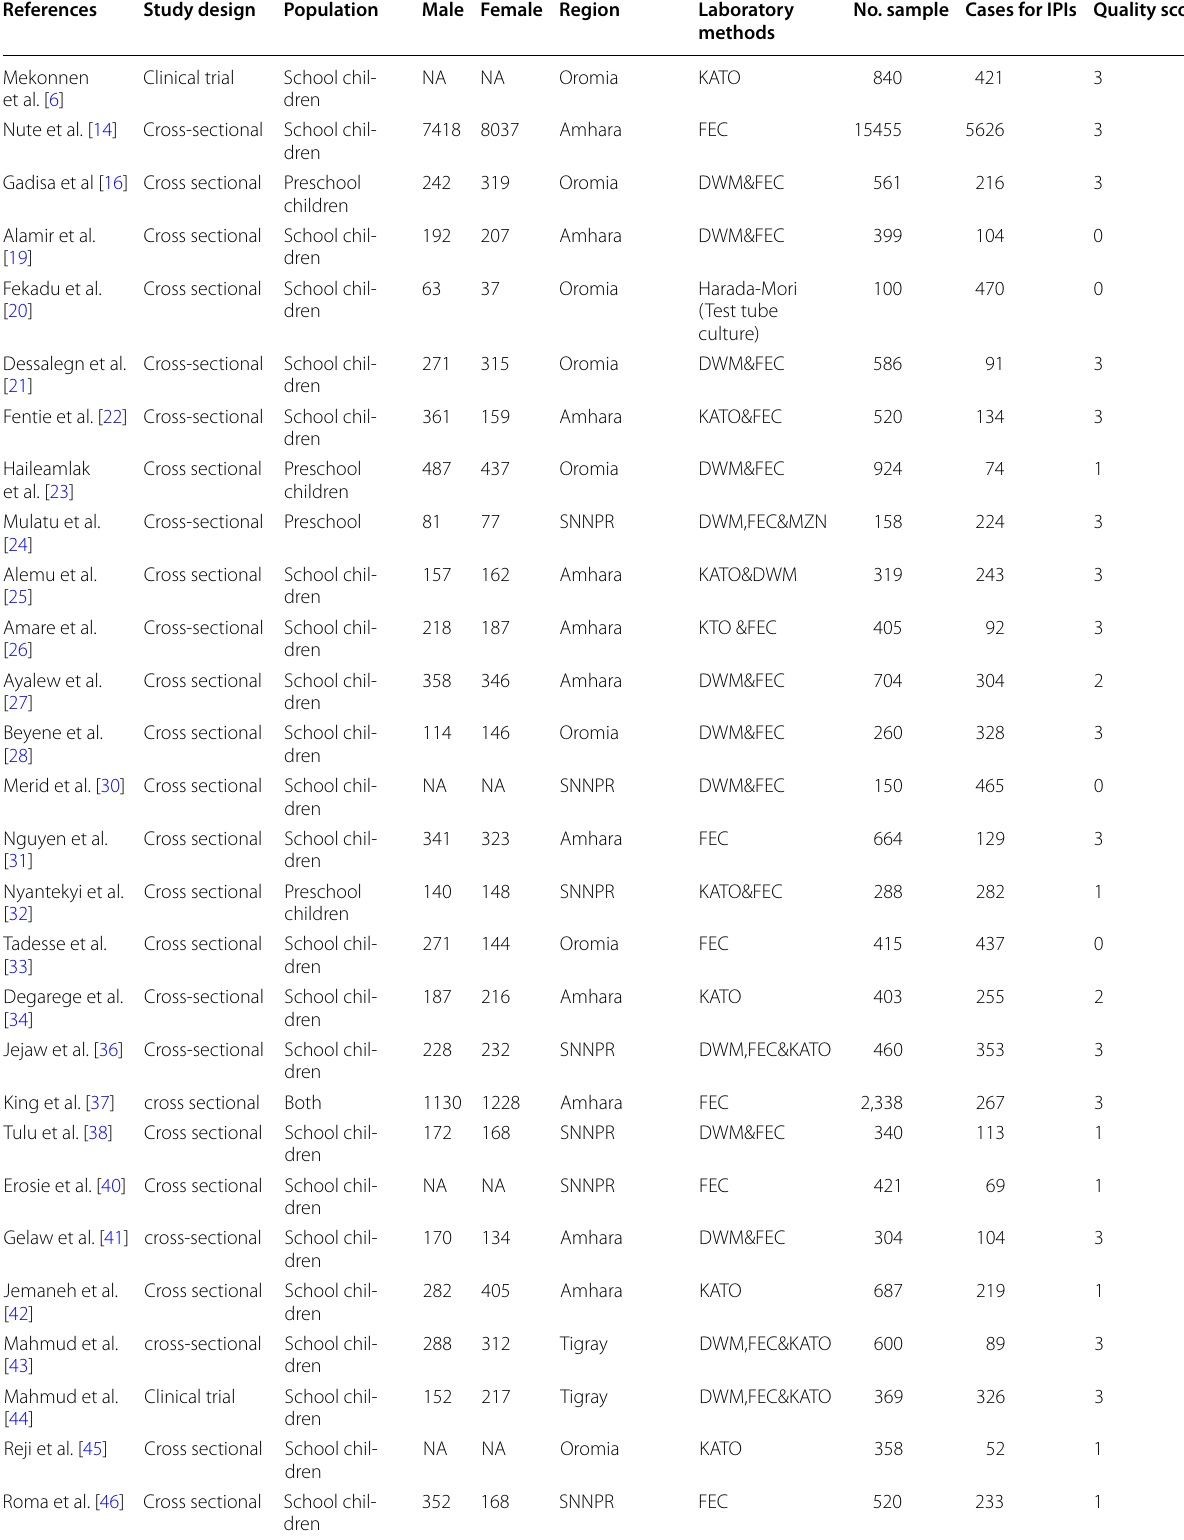
Table 1 Characteristics of the eligible studies on STH infections in